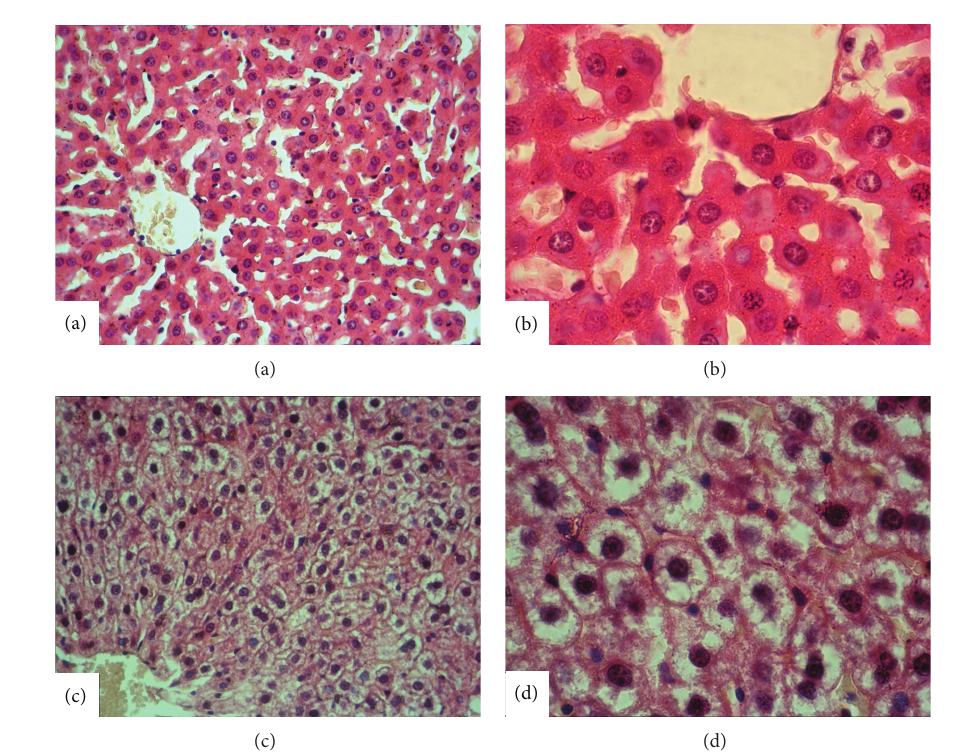
Figure 2: Liver histopathology ((a)-(b)): normal group liver, H&E ( × 40 and × 100 magnification), and ((c)-(d)): hepatosteatosis group liver (macrovesicular steatosis in liver